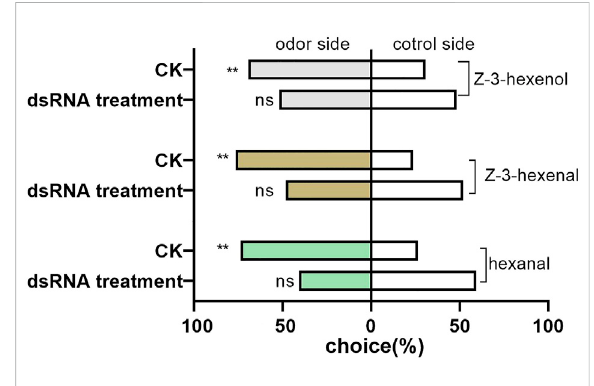
FIGURE 5 Behavioral response of D. tarsalis to three odorant signals for host location after DtarORco silencing. *represents signi fi cant difference,**represents extremely signi fi cant difference (n =